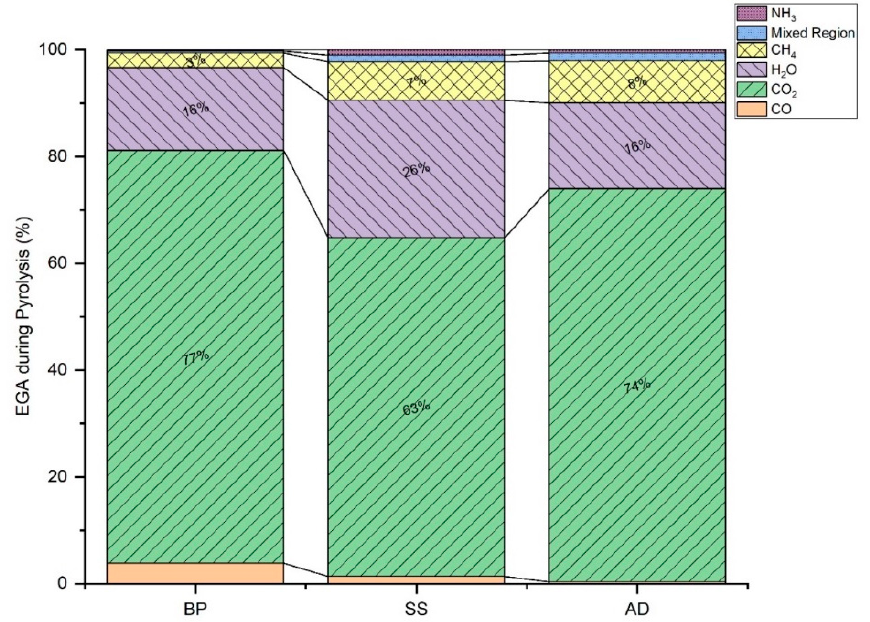
Figure 8. Normalized evolved gas analysis (EGA) during the pyrolysis of BP, SS and AD with HTT 745, 735, and 690 °C, respectively.